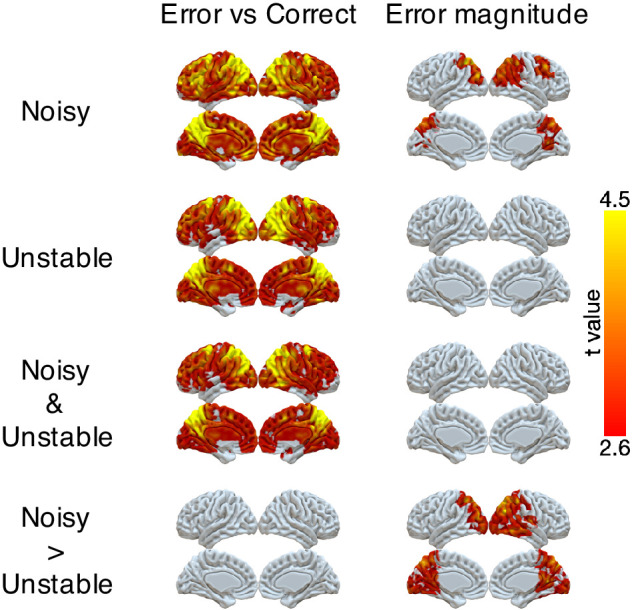
Representations of error and error magnitude.For error versus correct analyses, multi-voxel neural patterns were used to classify whether the response on the current trial was correct or an error. For error magnitude analyses, multi-voxel neural patterns were used to classify different error magnitudes (1, 2, 3+) conditional on the current trial being an error. Accuracies were calculated and compared with the baseline accuracy within each subject and then tested at the group level. The representation of current error magnitude is stronger in parietal cortex in the noisy condition than the unstable condition. The cluster-forming threshold was an uncorrected voxel p<0.01 (t = 2.6), with cluster mass corrected for multiple comparisons using non-parametric permutation tests.